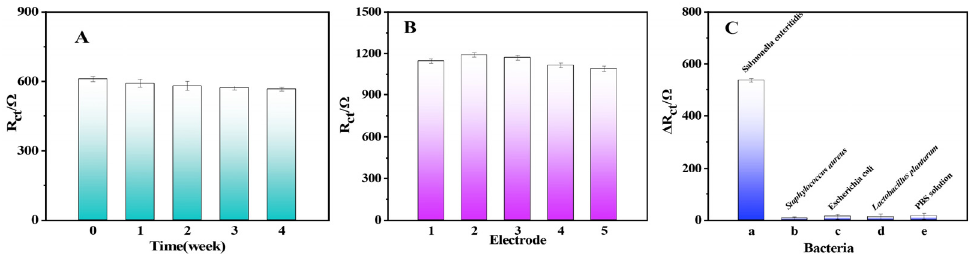
Figure 5. ( A ) Stability, ( B ) reproducibility, and ( C ) specificity studies of the renewable